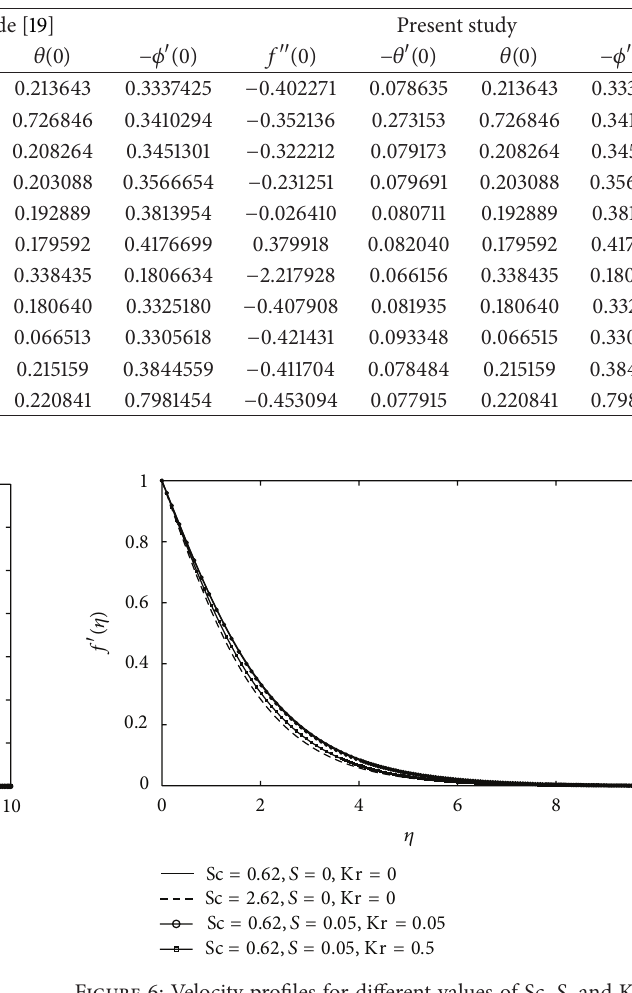
Figure 6: Velocity profiles for different values of Sc, 𝑆 , and Kr for Ha = 0.1 , Gr = 0.1 , Gc = 0.1 , Bi = 0.1 , Nc = 0.01 , and Pr = 0.72 . Table 2: Computation of skin friction ( 𝑓 󸀠󸀠 (0) ), Nusselt number ( −𝜃 󸀠 (0) ), plate surface temperature ( 𝜃(0) ), and Sherwood number ( −𝜙 󸀠 (0) )fordifferentvaluesofBi,Pr, 𝑆 ,andKr.Theotherparameters are Ha = 0.1 , Gr = 0.1 , Gc = 0.1 , Sc = 0.62 , and Nc = 0.01